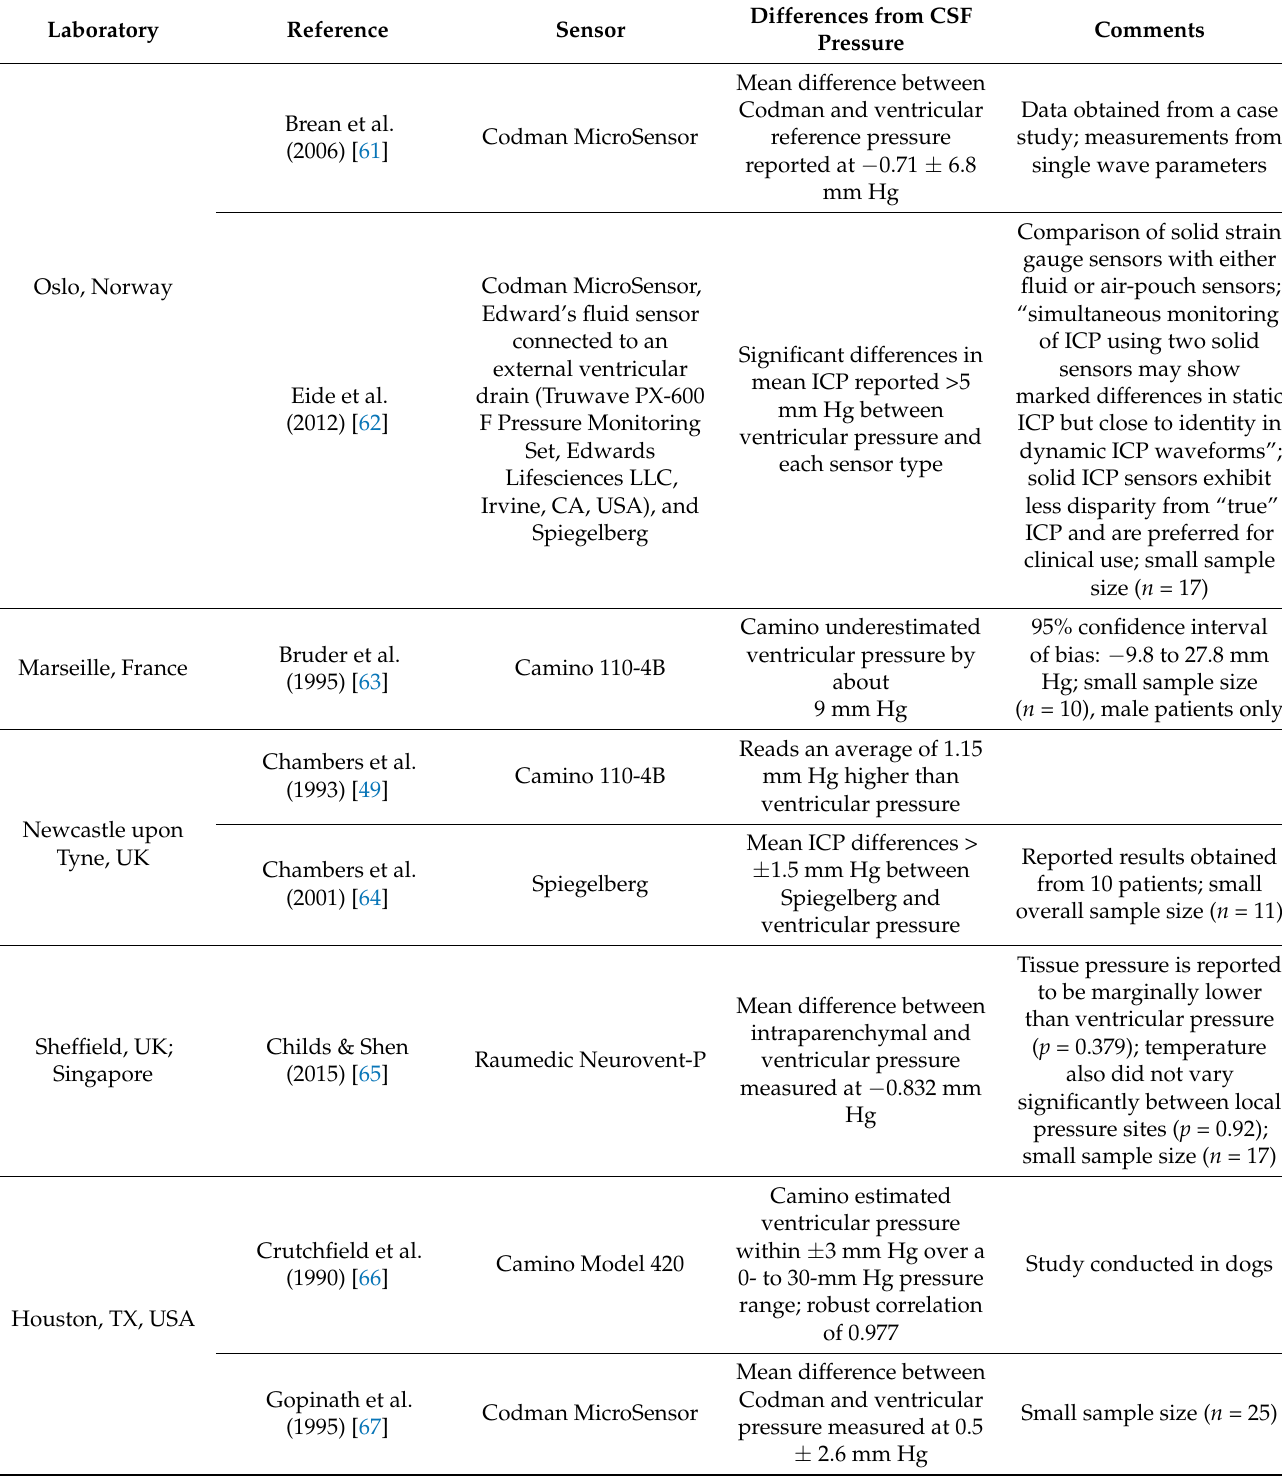
Table A3. Agreement between Intraparenchymal Sensors and CSF Pressure in Clinical